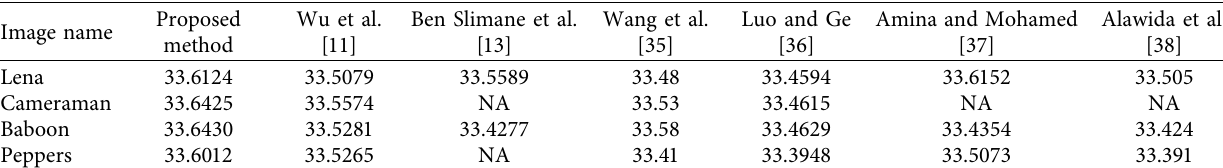
Table 4: The UACI (%) of encrypted images for our approach compared with other literature algorithms. Note that NA stands for “not